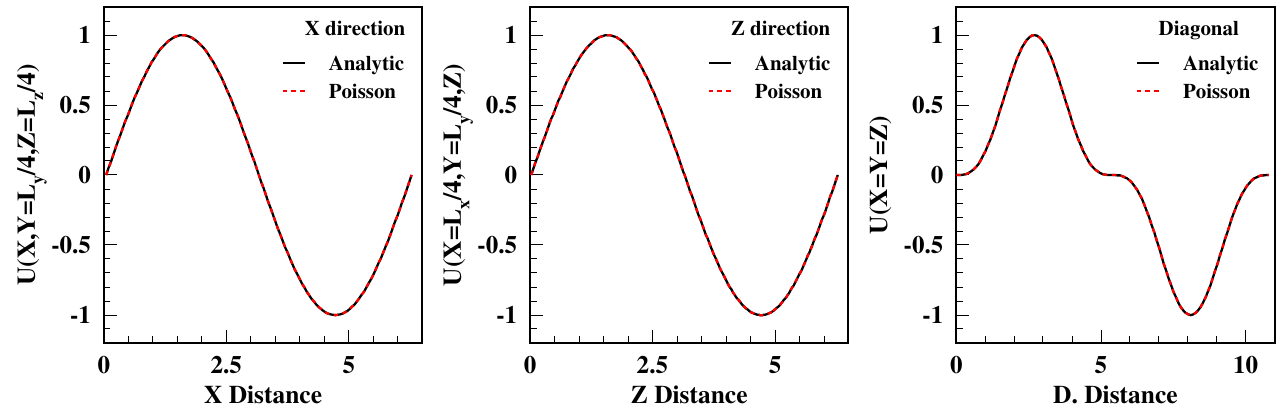
FIG. 5. (Color) Comparison of the results from the parallel Poisson solver to the analytical solution U (cid:6) x; y; z (cid:7) (cid:4) sin (cid:6) x (cid:7) sin (cid:6) y (cid:7) sin (cid:6) z (cid:7) of the equation: (cid:1) U (cid:6) x; y; z (cid:7) (cid:4) 3 (cid:3) sin (cid:6) x (cid:7) sin (cid:6) y (cid:7) sin (cid:6) z (cid:7) in a 2 (cid:2) (cid:3) 2 (cid:2) (cid:3) 2 (cid:2)